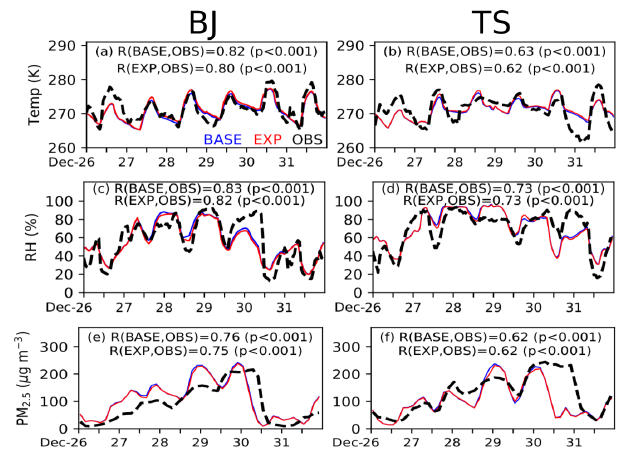
Figure 6. Time series of observed and simulated (a, b) 2m temper- ature, (c, d) 2m RH, and (e, f) PM 2 . 5 concentration in (a, c, e) Bei- jing and (b, d, f) Tangshan from 26 to 31 December in 2017. The simulations of the BASE run are denoted with blue lines, and those of the EXP run are denoted in red lines. The correlation coefficients ( R ) between the observations and simulations are also given for each